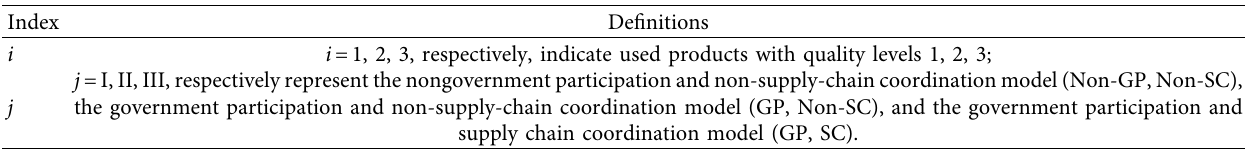
Figure 1: Decision framework for remanufacturing supply chain. Table 1: Indices.